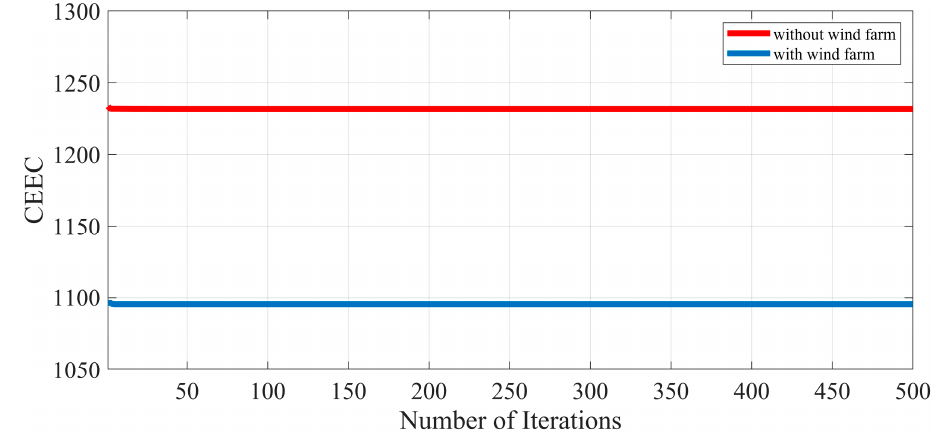
Figure 6. The convergence curves for emission minimization for the Test System 1.